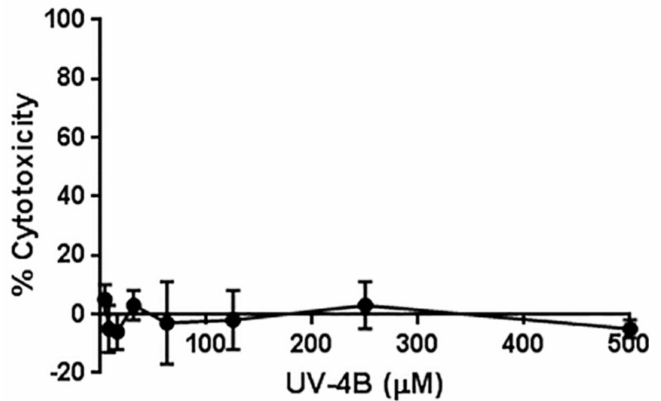
Figure 2. Cytotoxicity of UV-4B in differentiated normal human bronchial epithelial cells (EpiAirway™). Cytotoxic effects of UV-4B were determined in EpiAirway™ tissue on Day 3. An average of four replicates at each concentration are plotted with standard